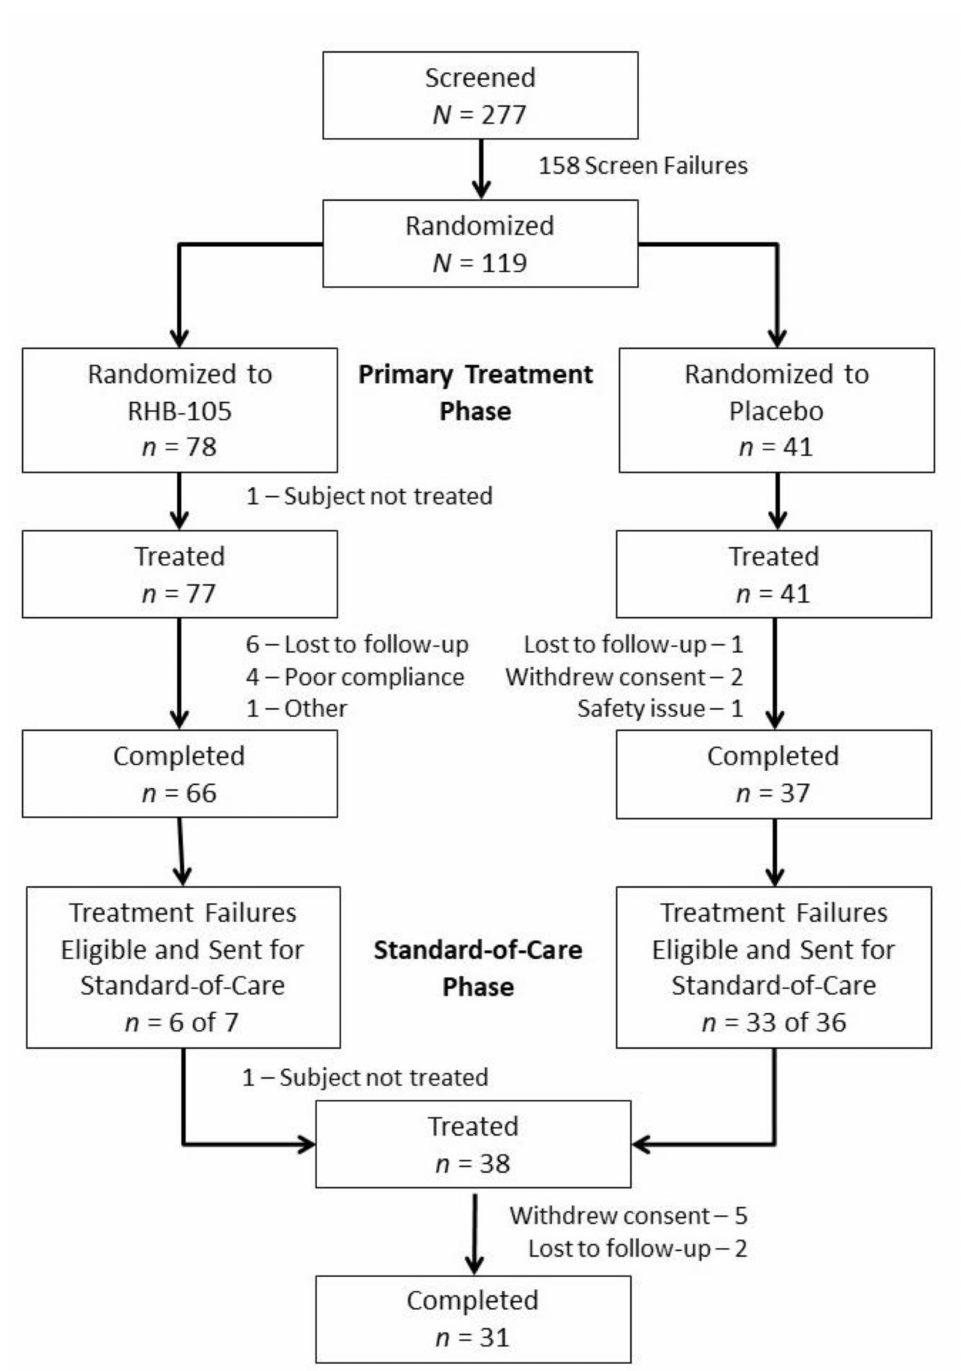
Figure 1. Consolidated Standards of Reporting Trials (CONSORT)